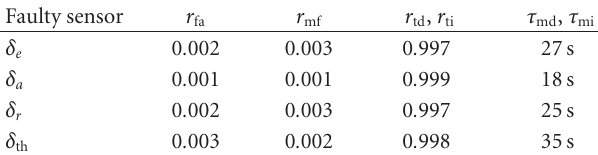
Table 7: PM Monte Carlo analysis with ν = 4 and p = 10%.